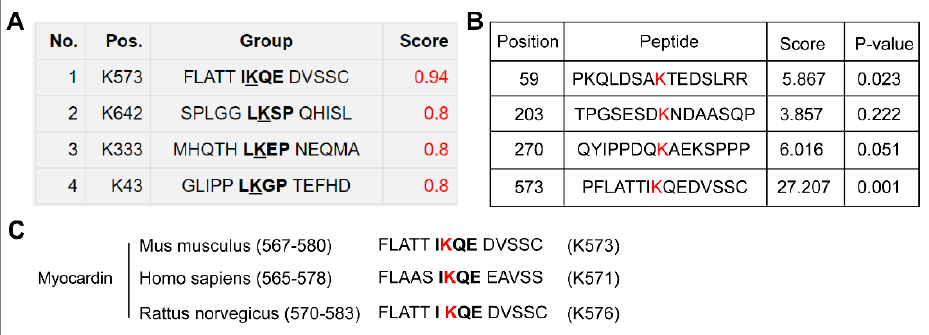
Figure 1. The prediction and conservation of SUMOylation sites in myocardin. ( A , B ) The putative SUMOylation sites in myocardin isoform B (Mus musculus) were predicted by the SUMOplot TM Analysis Program online tool (https://www.abcepta.com/sumoplot, accessed on 18 February 2022) ( A ) and SUMOsp2.0 software ( B ). One lysine residue (lysine 573) was consistent in the results. ( C ) Alignment of orthologous myocardin amino acid sequences in Mus musculus , Homo sapiens , and Rattus norvegicus indicates evolutionary conservation of SUMOylation sites in myocardin. ( A – C ), The canonical SUMO-binding motif is defined as ψ KX(D/E), where ψ represents an aliphatic or hy- drophobic amino acid residue, ‘K’ in the consensus sequence is the SUMO acceptor lysine, and ‘X’ is any amino acid, which is adjacent to an acidic residue